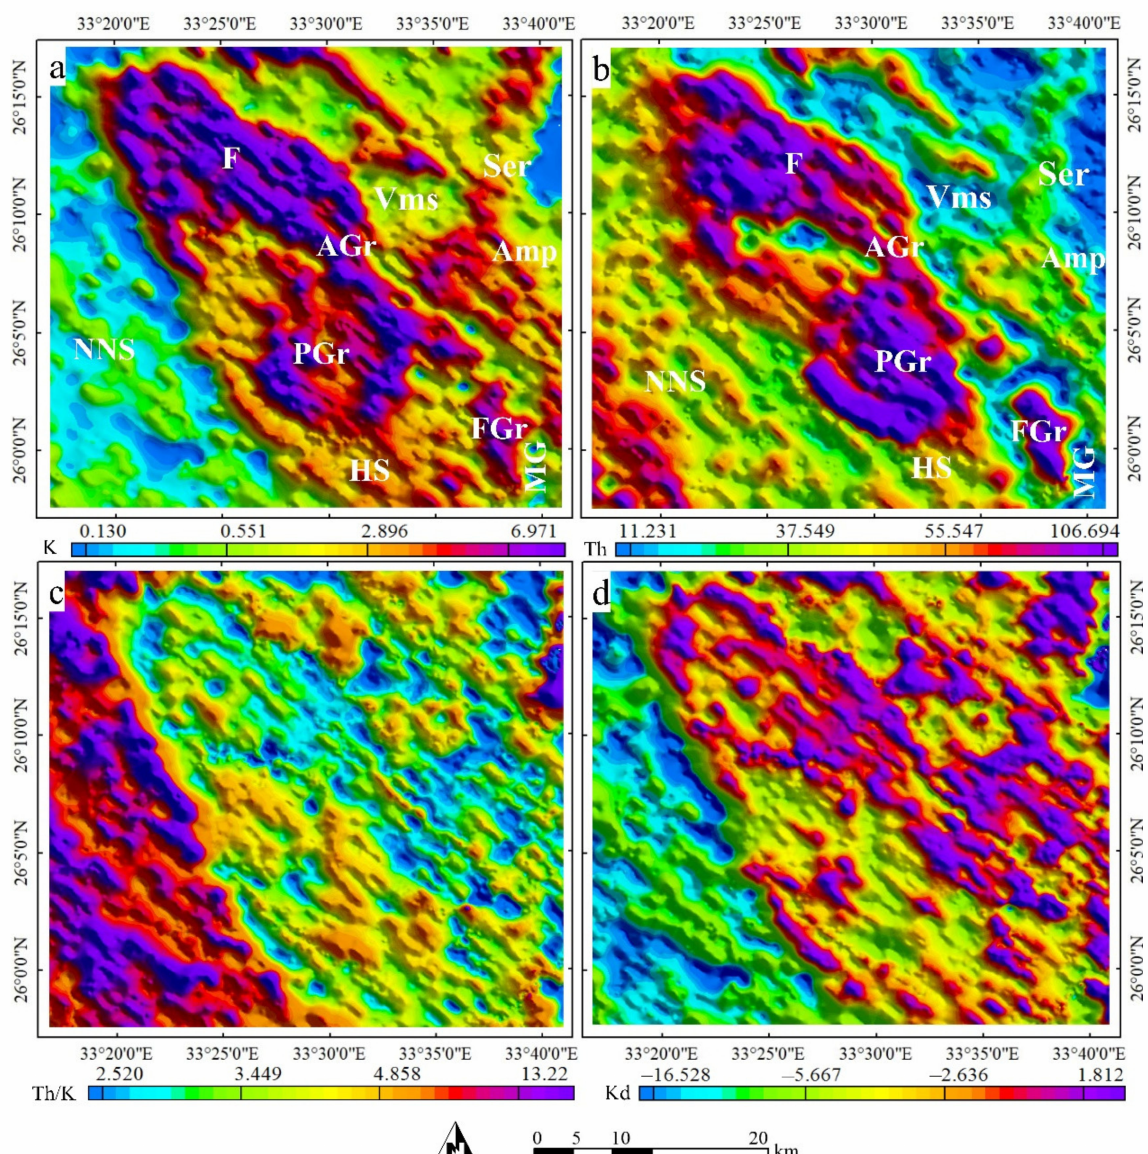
Figure 5. Spectrometric gamma-ray results: ( a ) potassium concentration, ( b ) thorium concentration, ( c ) thorium–potassium ratio map, and ( d ) kd anomalies